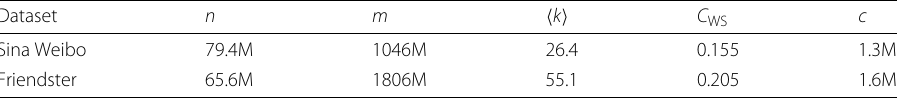
Table 1 Information on the two huge social networks analyzed